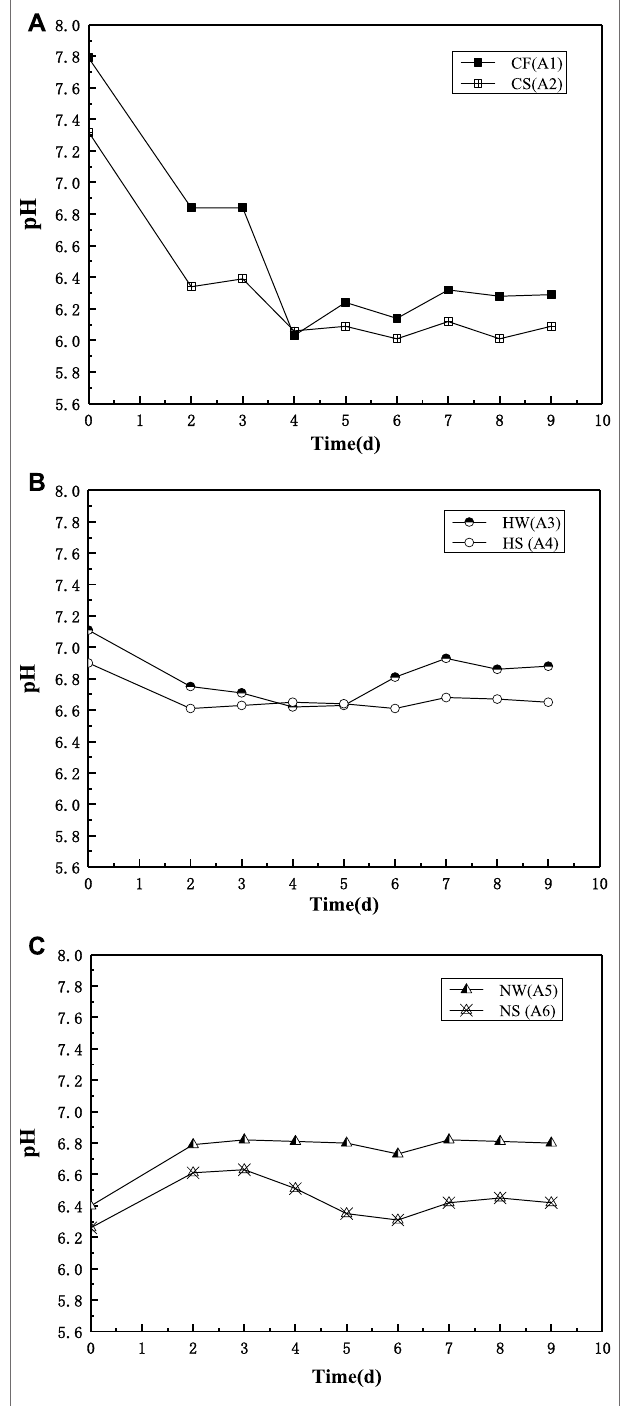
FIGURE 2 | pH in Group A of freshwater and seawater environment. (A) Group A CaCl 2 , (B) Group A Ca(CH 3 COO) 2 ; (C) Group A Ca(NO 3 ) 2 .